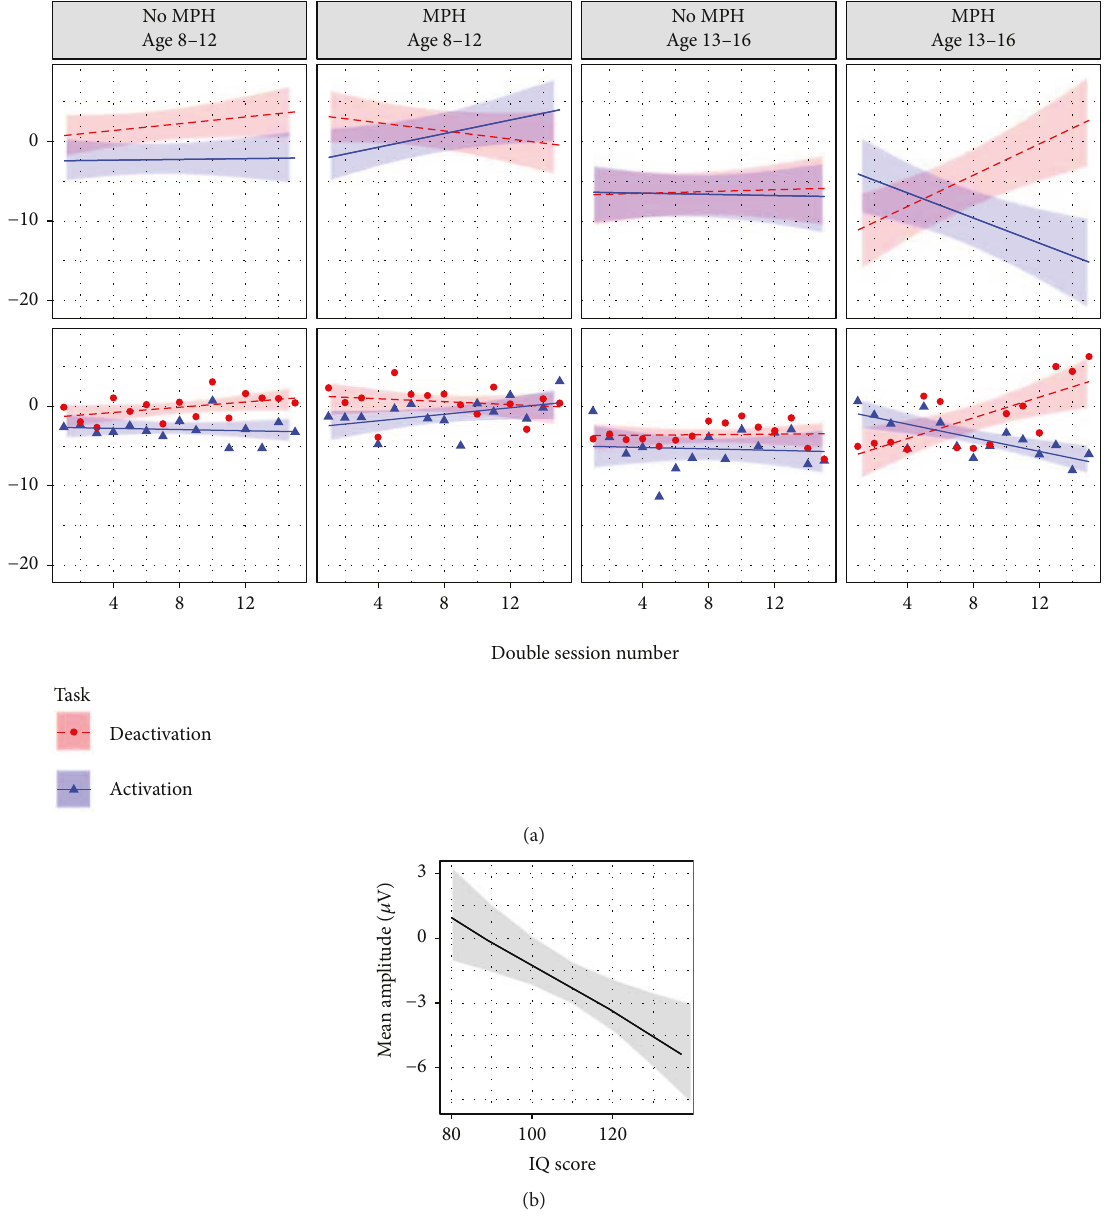
Figure 3: Visualization of e ff ects moderating cross-session NF learning in the feedback condition. The dependent variable is mean amplitude ( μ V) of baseline-corrected trials. (a) Interaction e ff ect between session, task, age, and MPH. For comparison between e ff ects and raw data, see scatter plot under each e ff ects panel, fi tted with a least squares regression based on the same factors as in the e ff ect plots. Session number: 15 training sessions in total. Task. Deactivation: generation of positive potential shifts. Activation: generation of negative potential shifts. MPH: being on constant methylphenidate medication. Feedback condition: feedback stimulus visible. For visualization, age is subdivided into two age classes (8 – 12 and 13 – 16 years), but preserved as a continuous variable in the original model. (b) Visualization of IQ e ff ect. IQ is estimated based on the short form of the German WISC-IV